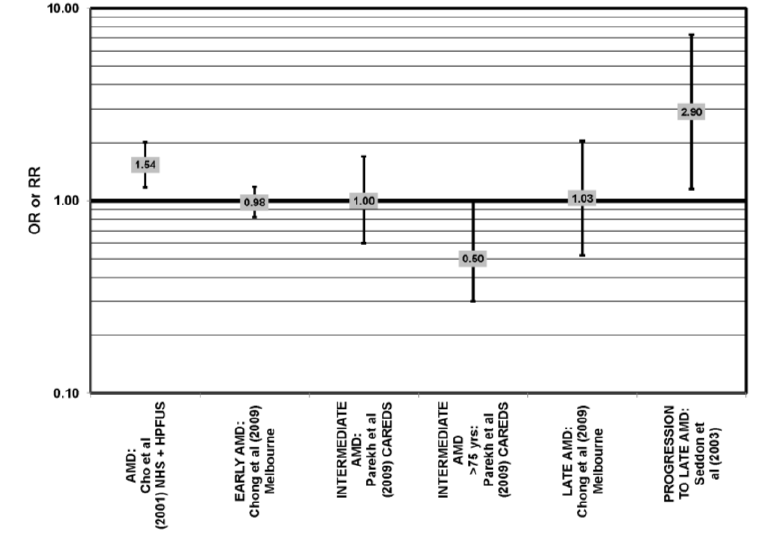
Figure 23. Odds or risk ratio for AMD, intermediate AMD or progression to late AMD; high vs. low intake of total fat: prospective